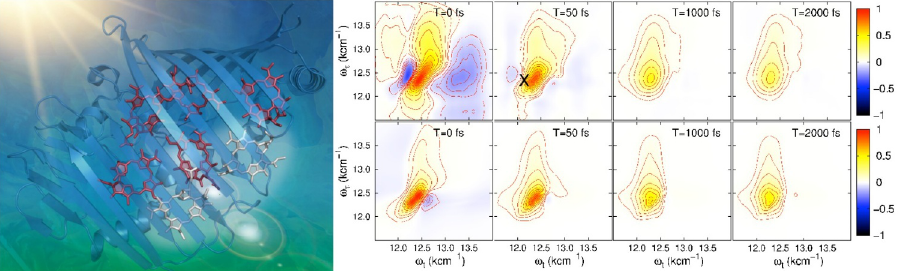
Fig. 1. Left: Molecular structure of the FMO protein complex. Right top: Representative 2D spectra measured at room temperature at different waiting times T as indicated. Right bottom: Calculated 2D electronic spectra at the same waiting